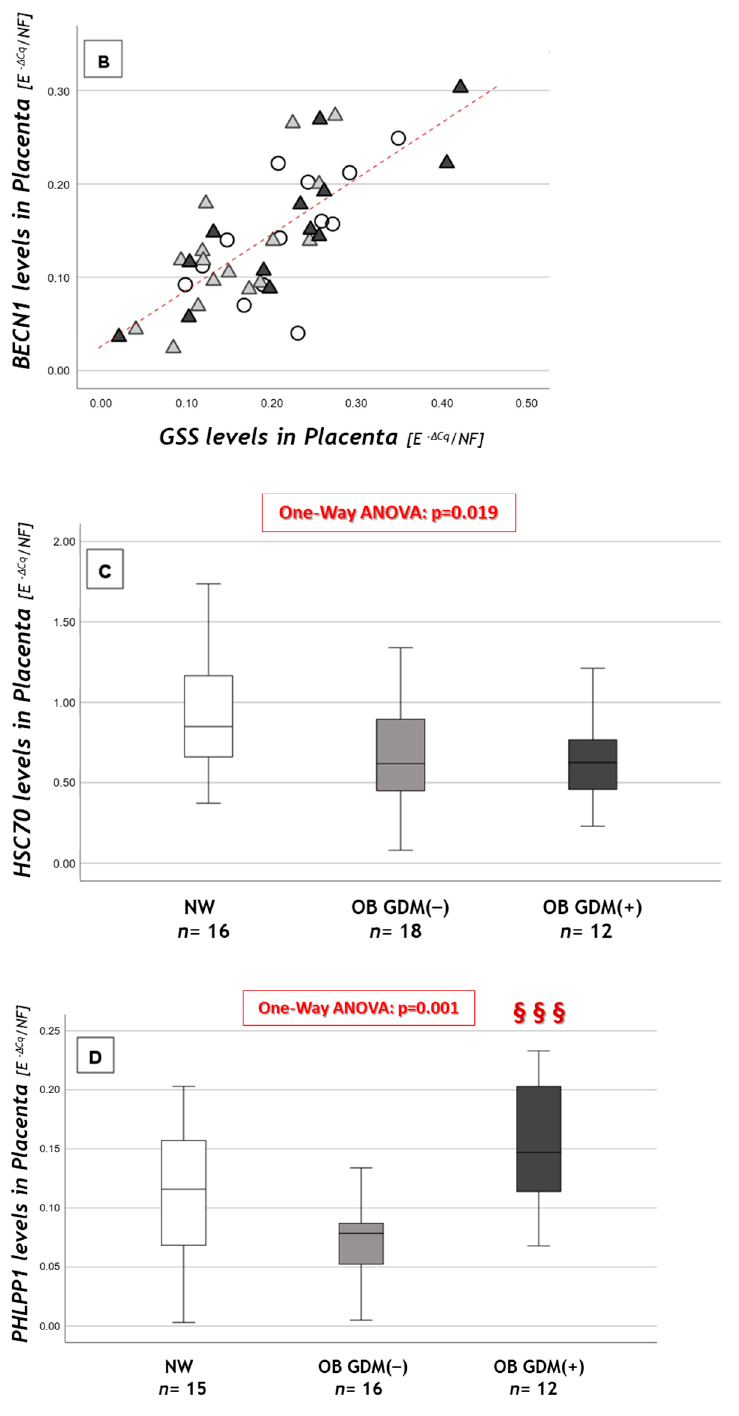
Figure 3. Expression of macroautophagy and CMA genes in placental tissue. ( A ) ULK gene expression levels, ( B ) correlation between GSS and BECN1 placental levels, ( C ) HSC70 gene expression levels and ( D ) PHLPP1 gene expression levels among NW, OB GDM( − ) and OB GDM(+). ( A , C , D ) Gene expressions were analyzed with Kruskal–Wallis test or One-way ANOVA ( ULK1 : p = 0.011; HSC70 : p = 0.019; PHLPP1 : p = 0.001). Data are shown as box plots, indicating the median and the 25th and 75th percentiles; ◦ values that extend more than 1.5 box-lengths from the edge of the box. §§§ p ≤ 0.001 vs. OB GDM( − ) (all Tukey HSD post hoc tests, except for ULK analyzed with Mann– Whitney U test and Bonferroni correction). ( B ) Statistical analysis by the Spearman rank order correlation (r = +0.76, p < 0.001) in NW ( ), OB GDM( − ) ( (cid:78) ), OB/GDM(+) ( (cid:78) (cid:35)